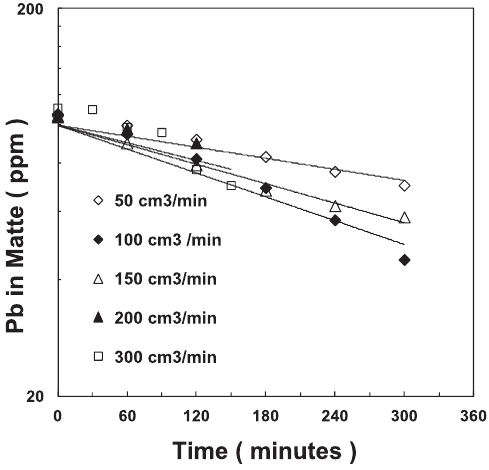
Fig. 2: Analyzed Pb content of a 50% Cu matte at 1300 °C bubbled with Ar flow rates of 50 to 300 cm 3 .min − 1 . Note shorter bubbling duration for the 200 cm 3 .min − 1 and 300 cm 3 .min − 1 experiments.